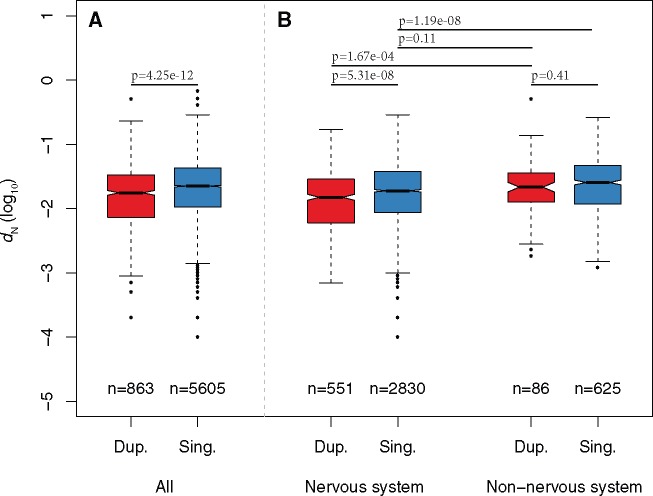
(A) Comparison of the rate of protein sequence evolution (dN, plotted in log10 scale) for mouse orthologs of zebrafish 3R ohnologs (“Dup.”) or singletons (“Sing.”). The number of genes in each category is indicated below each box. The P-values from a Wilcoxon test comparing categories are reported above boxes. The lower and upper intervals indicated by the dashed lines (“whiskers”) represent 1.5 times the interquartile range, or the maximum (respectively minimum) if no points are beyond 1.5 IQR (default behavior of R function boxplot). (B) Similar to (A), but mouse orthologs of zebrafish 3R ohnologs and singletons are split according to their expression in the nervous system (“Nervous system” and “nonnervous system”). The numbers of duplicates and singletons genes do not add up to numbers of genes in (A) because only genes with in situ hybridization data were used for this analysis.